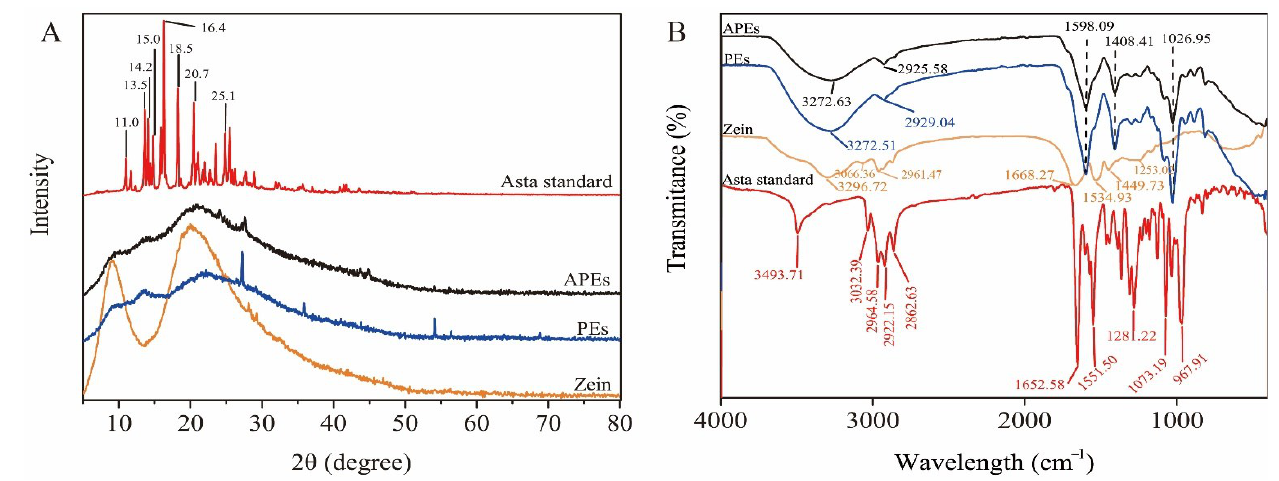
Figure 2. X-ray diffraction (XRD) and Fourier transform infrared spectroscopy (FTIR) spectra of APEs compared with PEs, zein and Asta standard. ( A ) XRD analysis in the range of 5 – 90°, and ( B ) FTIR analysis from 400 to 4000 cm − 1 .